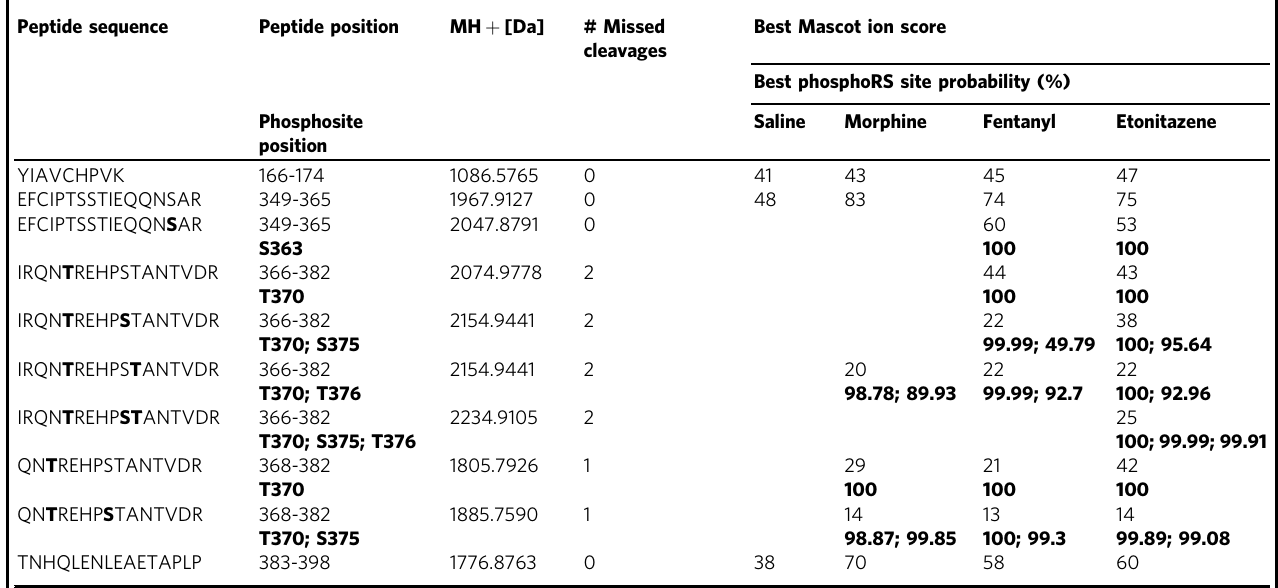
ListofMOPreceptorpeptidesandphosphopeptidesidenti fi edbynanoLC – MS/MSandtheircorrespondingMascotionscoreineachcondition.BelowtheMascotscore,phosphoRSsiteprobability(%)is given for each phosphorylated amino acid position (bold numbers). Positions are indicated for the canonical protein (P42866).